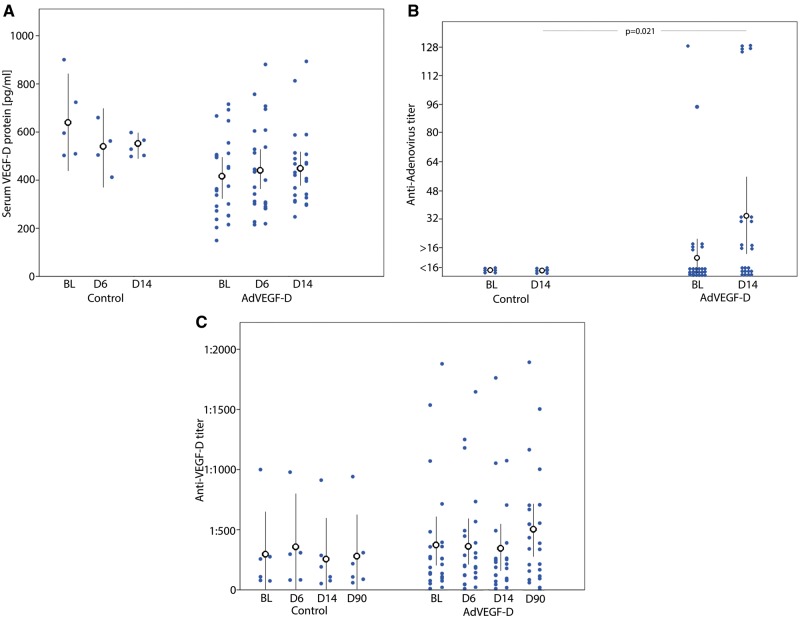
Serum VEGF-D protein levels (A), anti-adenoviral titers (B), and anti-VEGF-D titers (C) at baseline (BL) and 6 (D6), 14 (D14) and 90 (D90) days after gene transfer in controls (control) and AdVEGF-DΔNΔC treated patients (AdVEGF-D). Black dots and lines represent mean ± standard deviation. Blue dots represent values of individual patients.